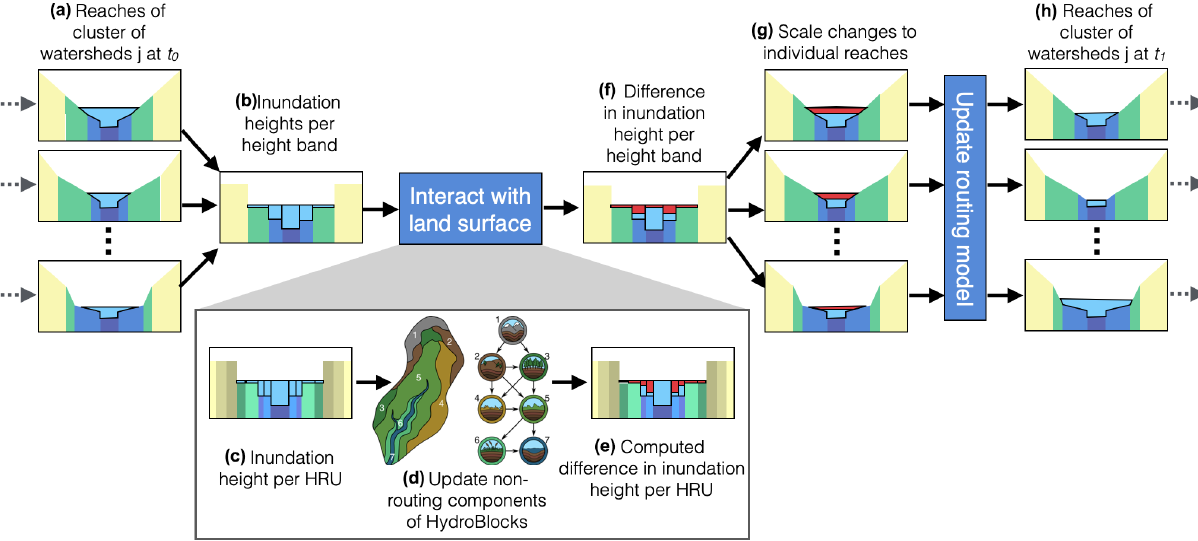
Figure 4. Floodplain inundation scheme implemented in HydroBlocks. After the routing module is updated for a given time step (a) , each reach’s computed cross-section profile is used to determine the inundation height over each of the height bands in a given reach. The inundation heights per height band are averaged across all watersheds in a given cluster of watersheds (b) . These inundation heights are then equally distributed to their corresponding HRUs (c) . To update the land surface model component, the computed inundation heights are added to the following time step as a constant flux at the soil surface to update the non-routing components of HydroBlocks (d) . The difference between the old and new inundation heights are computed (e) and averaged back up to the height band level (f) . The differences per height band at the cluster of watersheds level are first scaled to each watershed and then aggregated to compute the change in cross-sectional area (g) . This difference is then divided by the routing model time step and added to the routing module’s source–sink term S in the next iteration of the routing model (h)